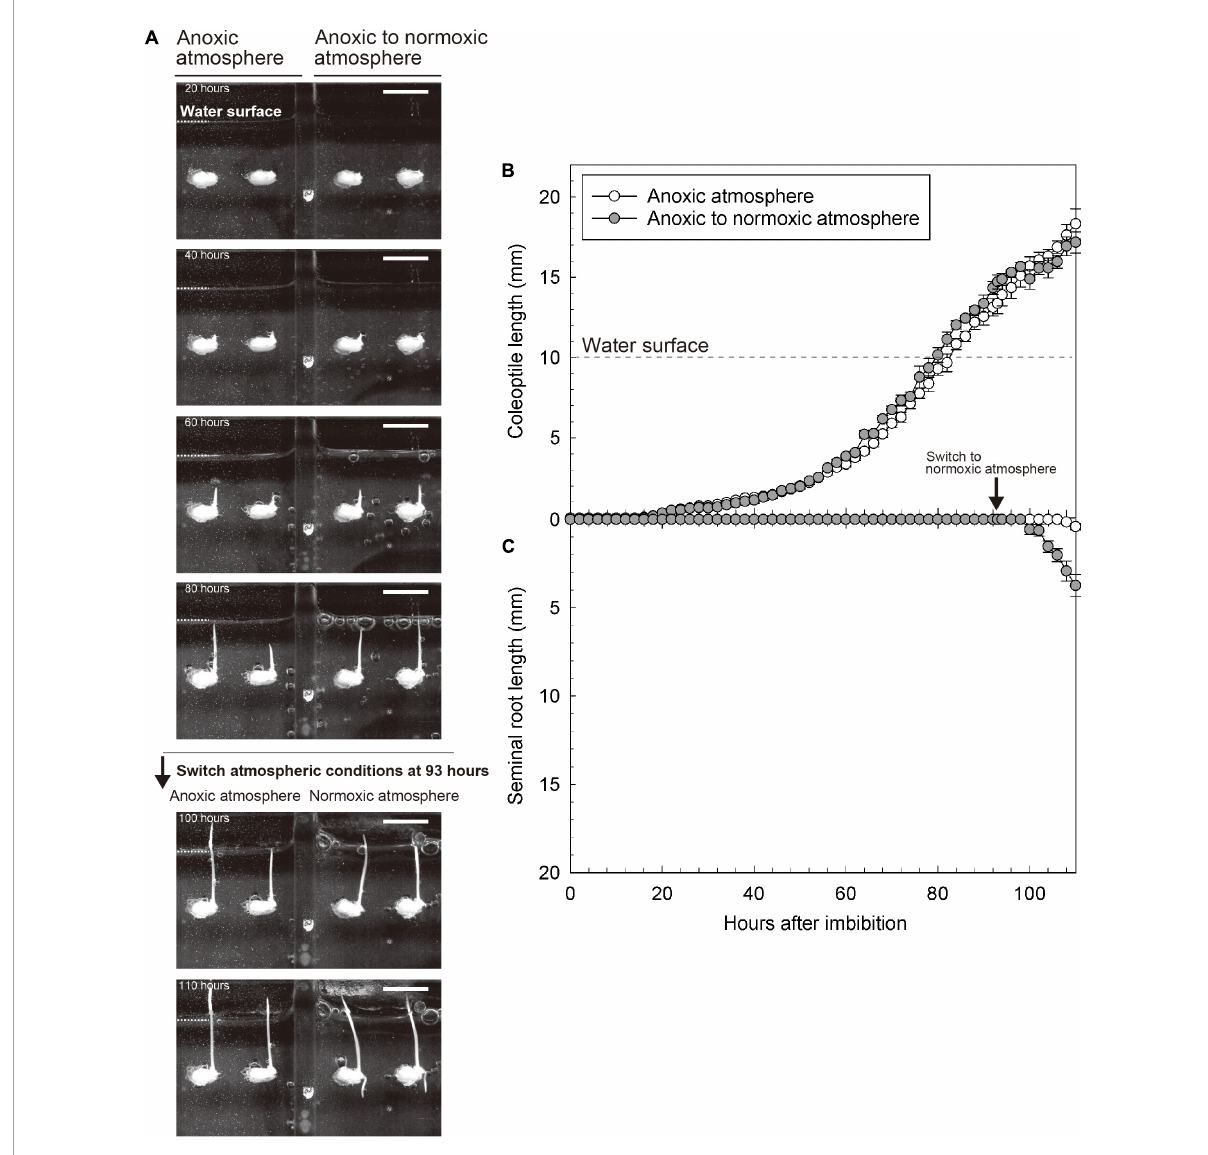
FIGURE3 Reaction of coleoptile and seminal root growth following the switching from anoxic to normoxic atmospheres. (A) An image sequence of the submerged germination processes. Bars = 10 mm. (B) Coleoptile length and (C) seminal root length during germination. Means ± SE, n = 3–5. At 93 h after imbibition, the atmospheric conditions were switched from anoxic to normoxic. The time lap images of growth responses following the switching from an anoxic to a normoxic atmosphere are shown in Supplementary Video 2